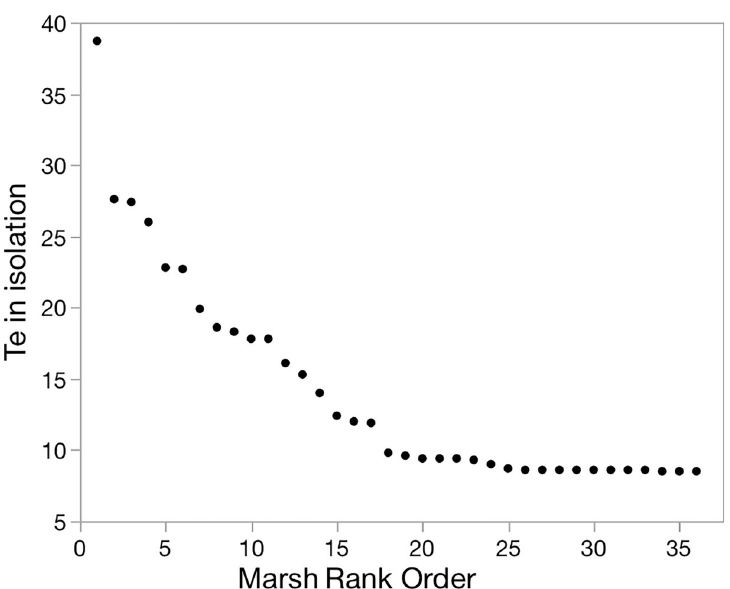
Fig 3. Estimated time to extinction for individual patches. Occupied marshes near Tecopa, California ranked by predicted times to extinction when subpopulation dynamics were simulated using the model metavole . R , assuming no other voles from outside marshes could access the query marsh (marsh in